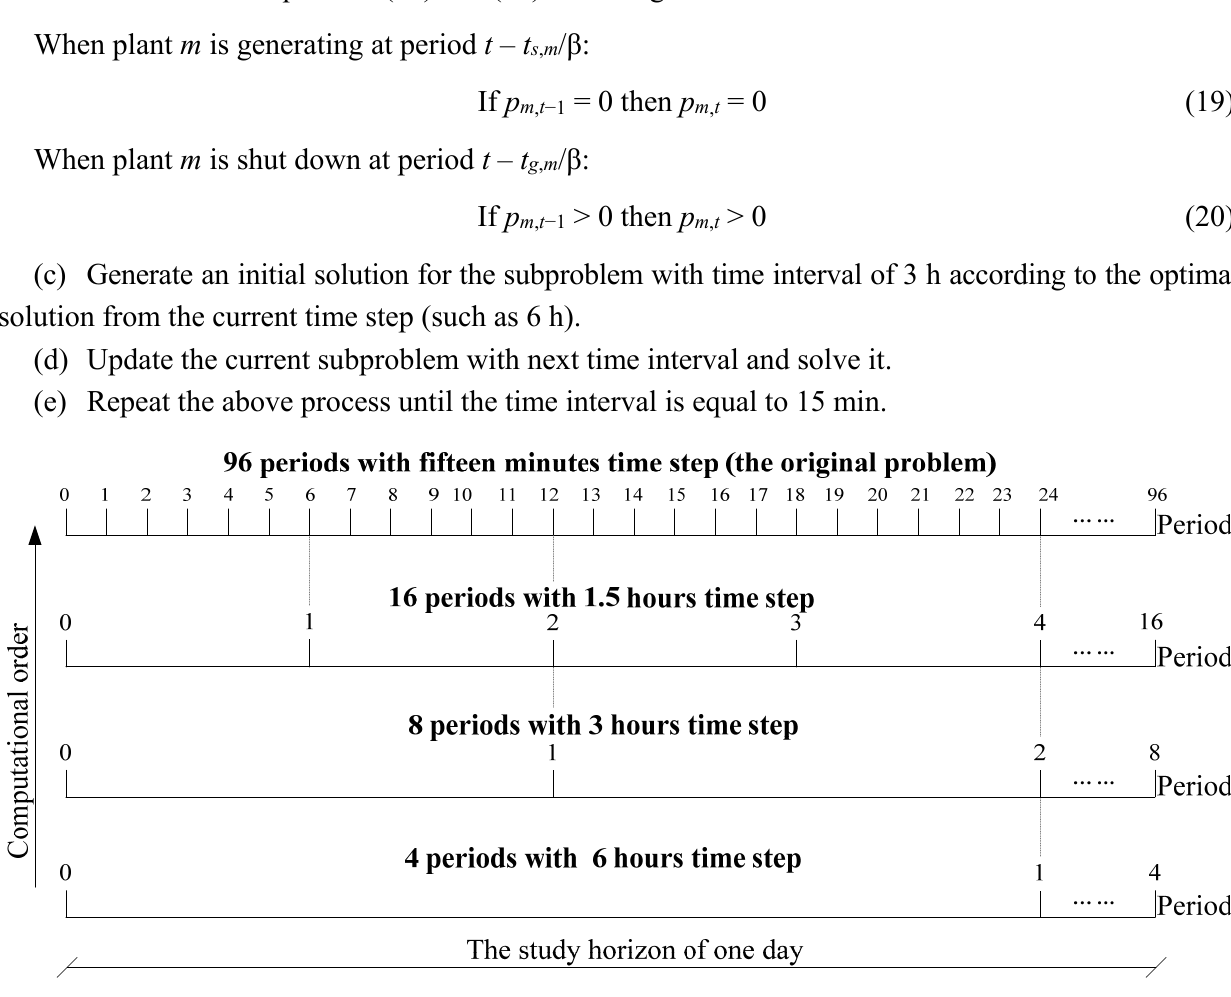
Figure 3. Different time scales for a set of short-term hydro scheduling